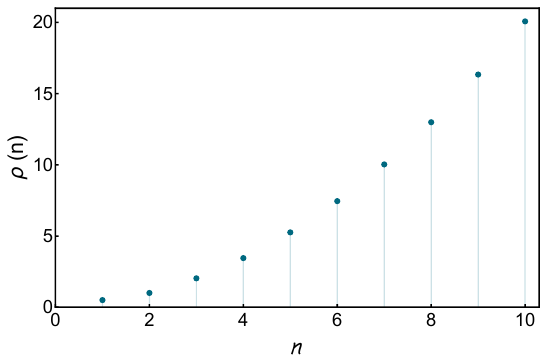
Figure 5 . Scaling of (cid:26) ( n ) [de(cid:12)ned in eq. (C.7)] with the monopole number n of generalized Weyl